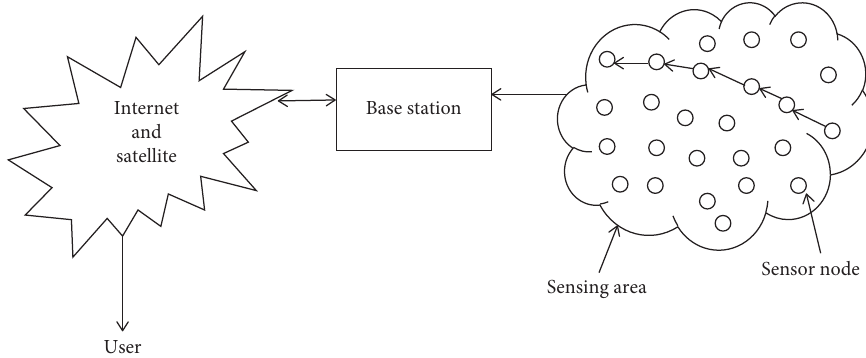
Figure 1: Wireless sensor network